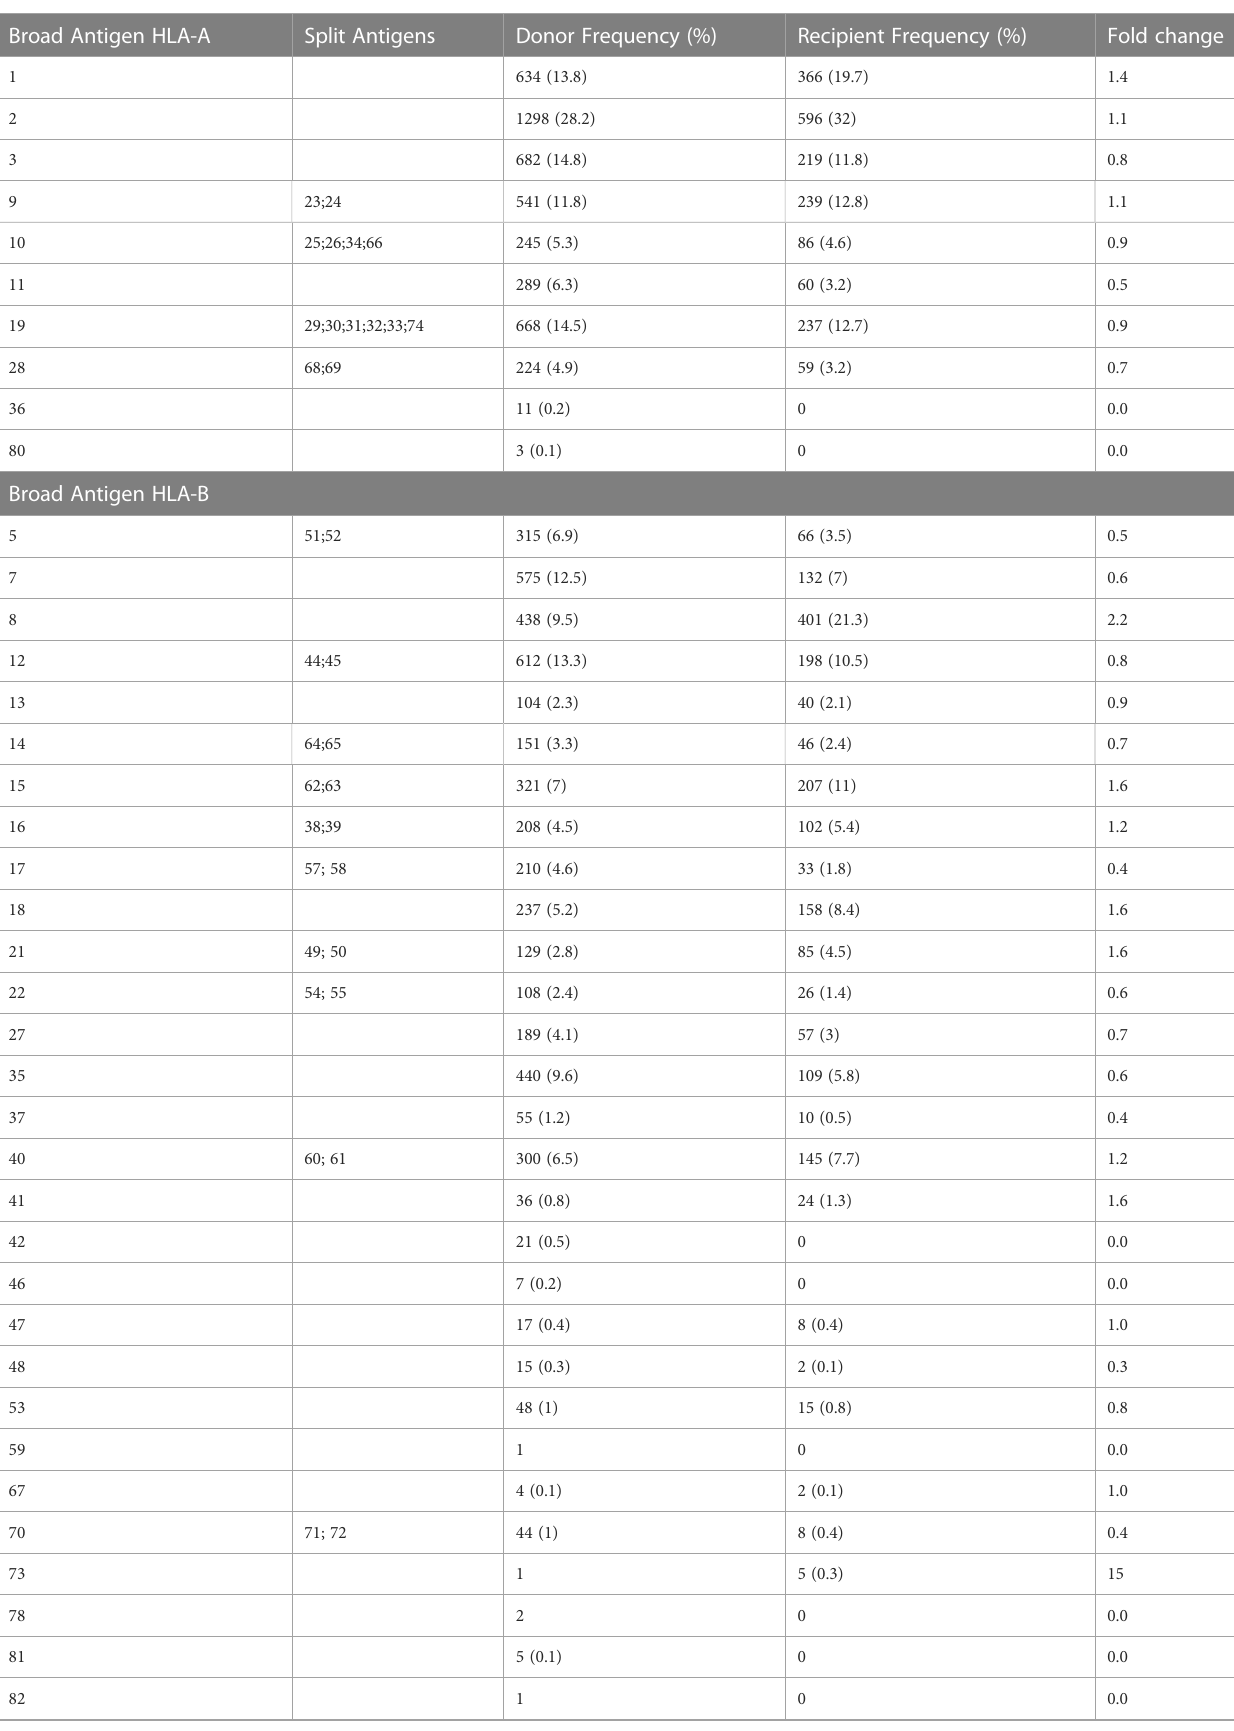
TABLE 1 Broad HLA speci fi cities in pancreas donor and islet